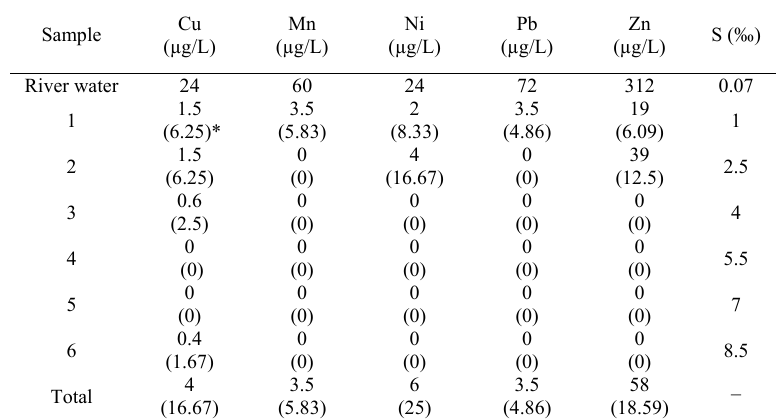
Table 5: Natural removal efficiency of metals during mixing of Sardabroud River water with Caspian Sea water